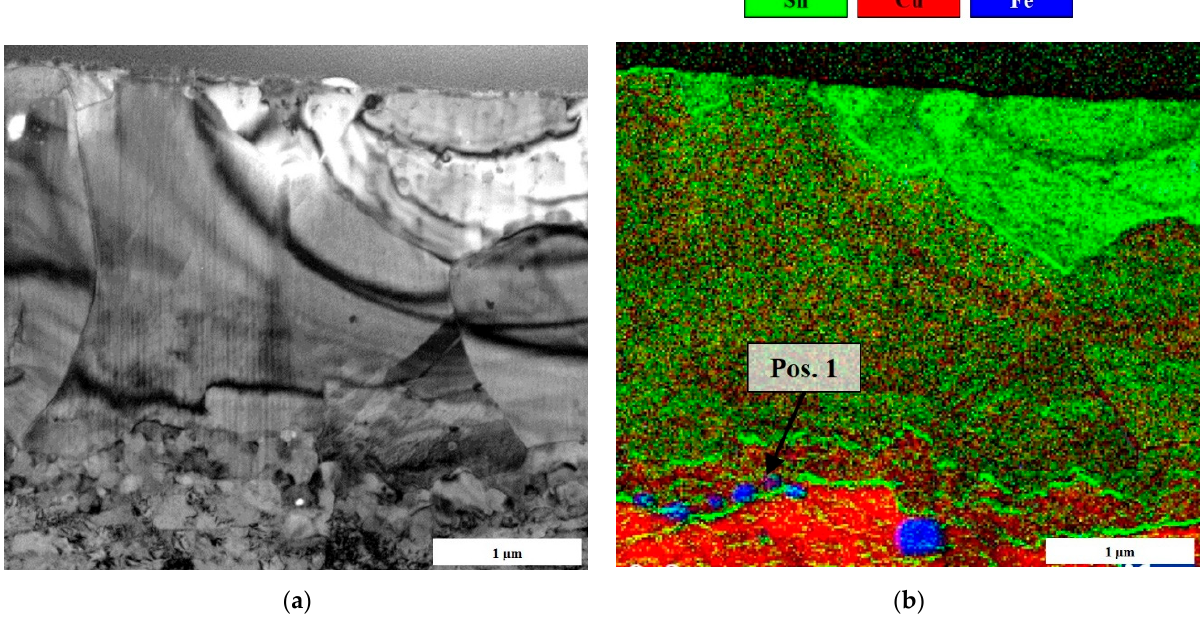
Figure 7. Analytical TEM investigations of electrical connectors stressed by temperature cycles over 200 h and maximum temperature of 140 °C (acceleration voltage 197 keV): ( a ) TEM imaging of the layer system; ( b ) EELS mapping for element investigation.